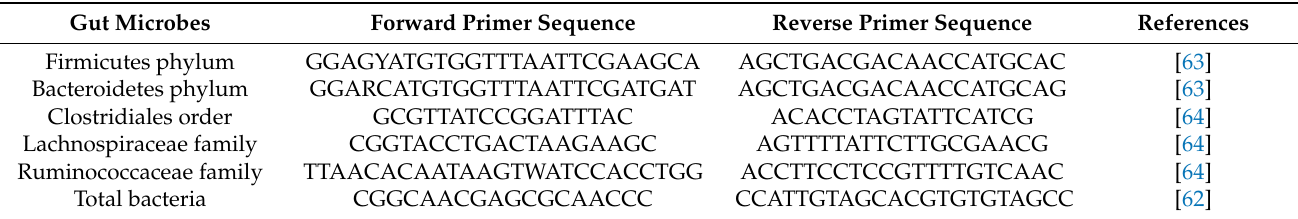
Table 1. The primer sequences of mice gut